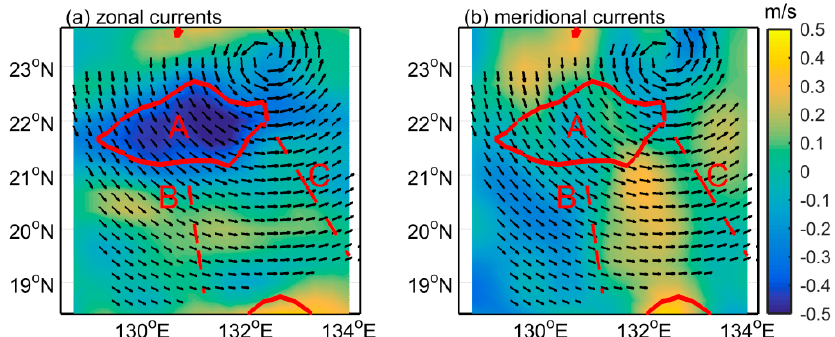
Figure 8. Decompositions of OSCAR currents in ( a ) zonal direction (positive is eastward and negative is westward); and ( b ) meridional direction (positive is northward and negative is southward). The wind vectors (black) as shown in Figure 5.